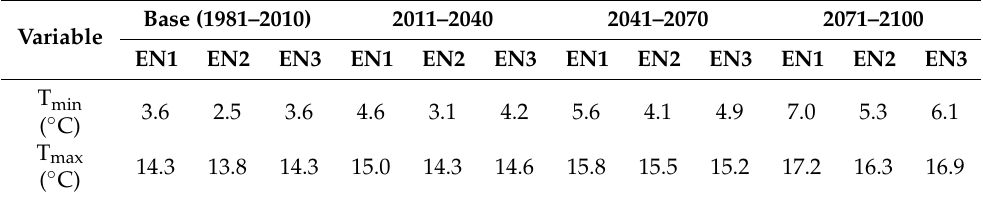
Table 5. Projected averaged minimum and maximum temperatures (1981–2100).